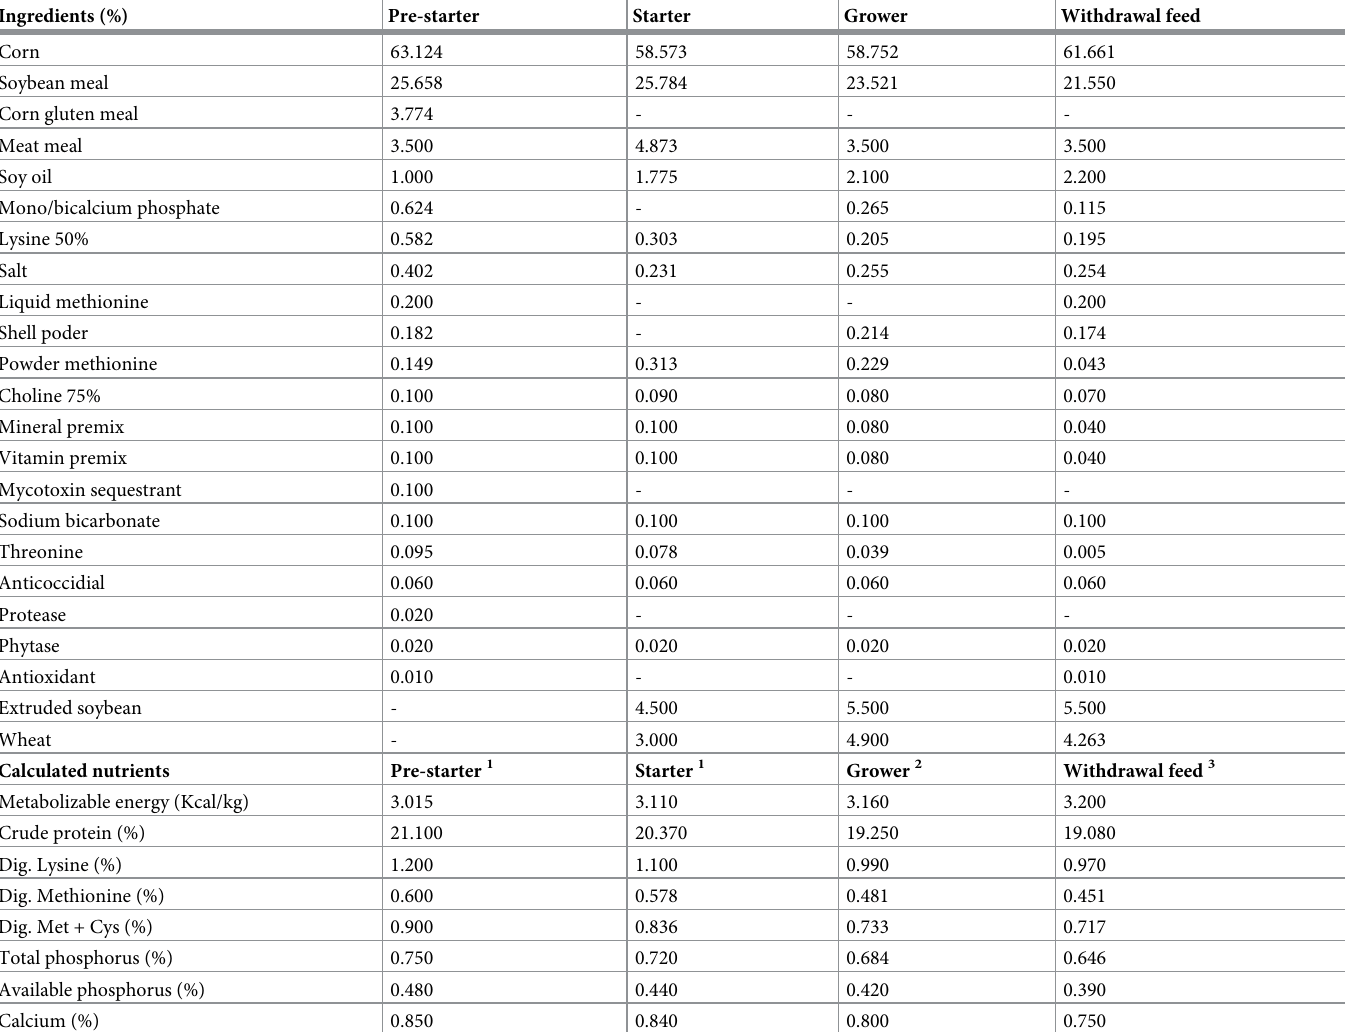
Table 1. Dietary composition and nutrient